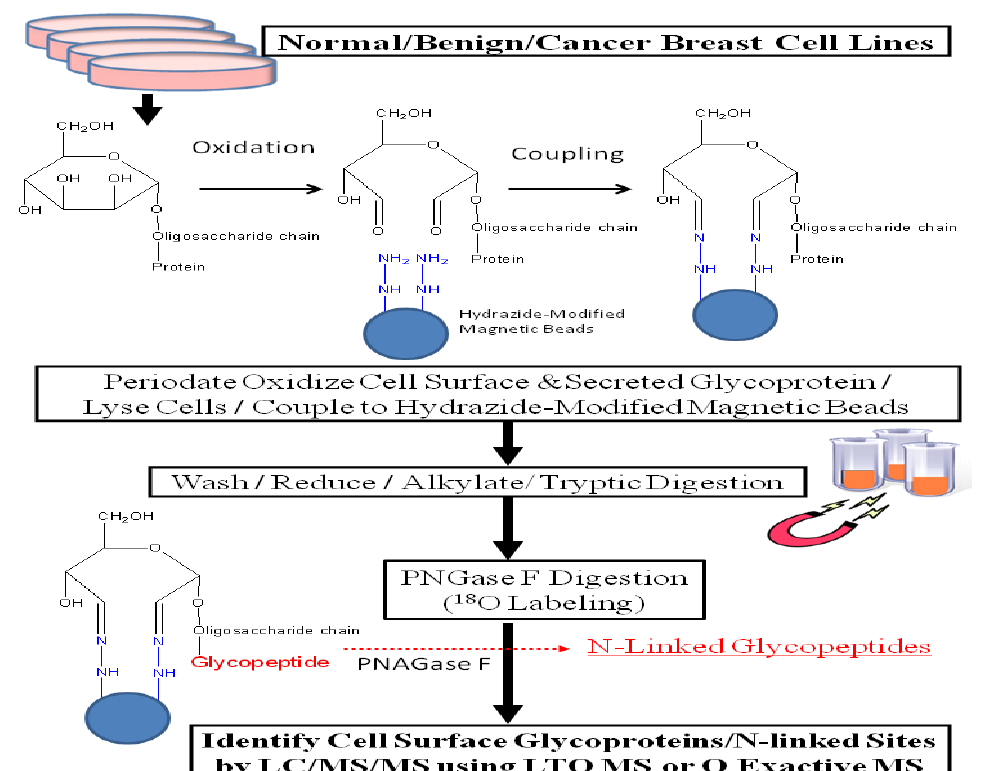
Figure 1. Experimental workflow